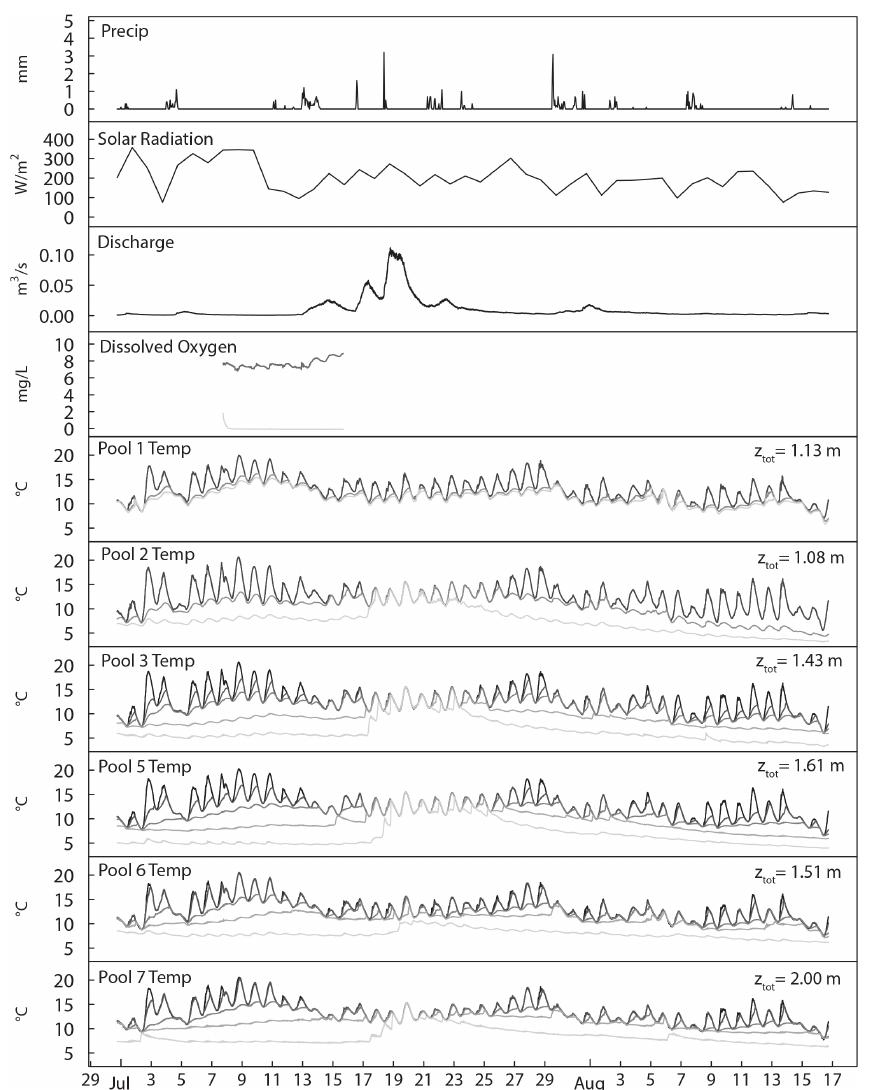
Figure 3. Imnavait Creek precipitation, solar radiation, discharge (at location downstream of study reach), dissolved oxygen in pool 2 top and bottom, and vertical arrays (VA) of temperature sensors within each study pool ( P ) in summer 2011. The darkest lines represent the sensor at the top of the water column; subsequent lines become lighter with depth of each sensor. The sensors were placed in each pool starting 5 to 15cm from the bottom of the pool and then at intervals ranging from 5 to 50cm over the depth of each pool ( z tot ) as indicated in the